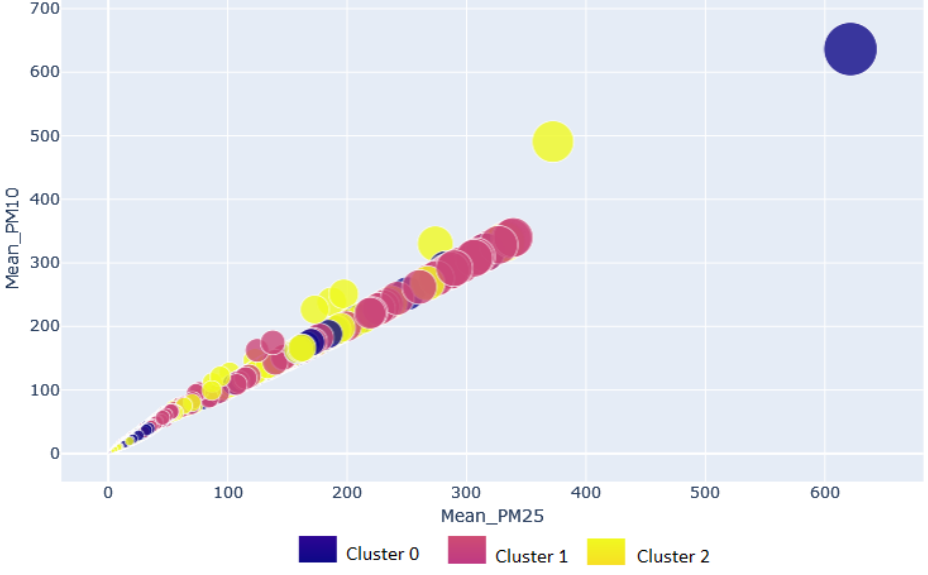
Figure 8. Clustering plot for outdoor pollution data.